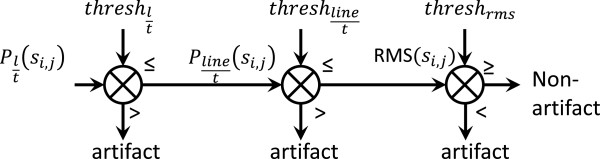
Schematics of the algorithm for the detection of low quality signals. The symbols (>) or (<) represent the cases where the feature was expected to be higher or lower than the specified threshold in order to determine if a given signal was labeled as artifact.